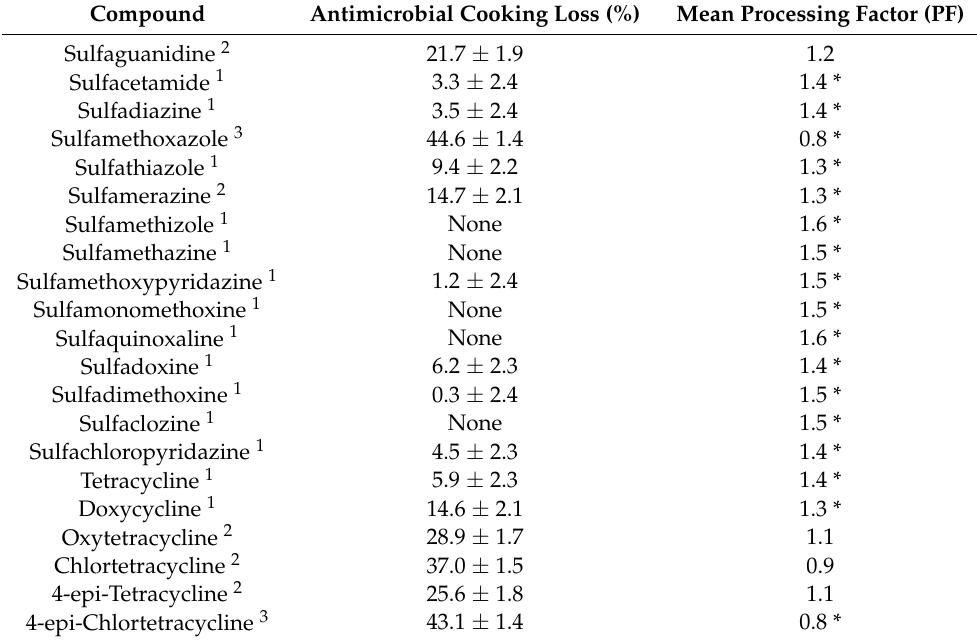
Table 1. Losses of sulfonamides and tetracyclines during medium cooking and corresponding processing factors. Antimicrobial losses were determined according to Rawn et al. [26], considering the mass of meat before and after cooking. Concentrations of sulfonamides and tetracyclines in raw and medium-cooked meat are reported in Table S1 (Supplementary Material).